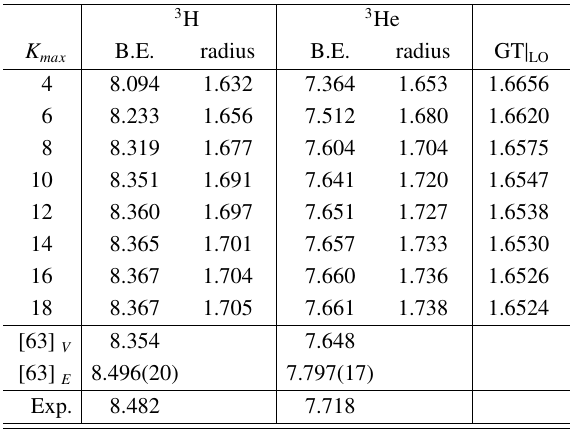
Table 2. The JISP16 NN interaction 3 He, 3 H binding energies, rms matter radius, and the leading order GT matrix element as a function of K max